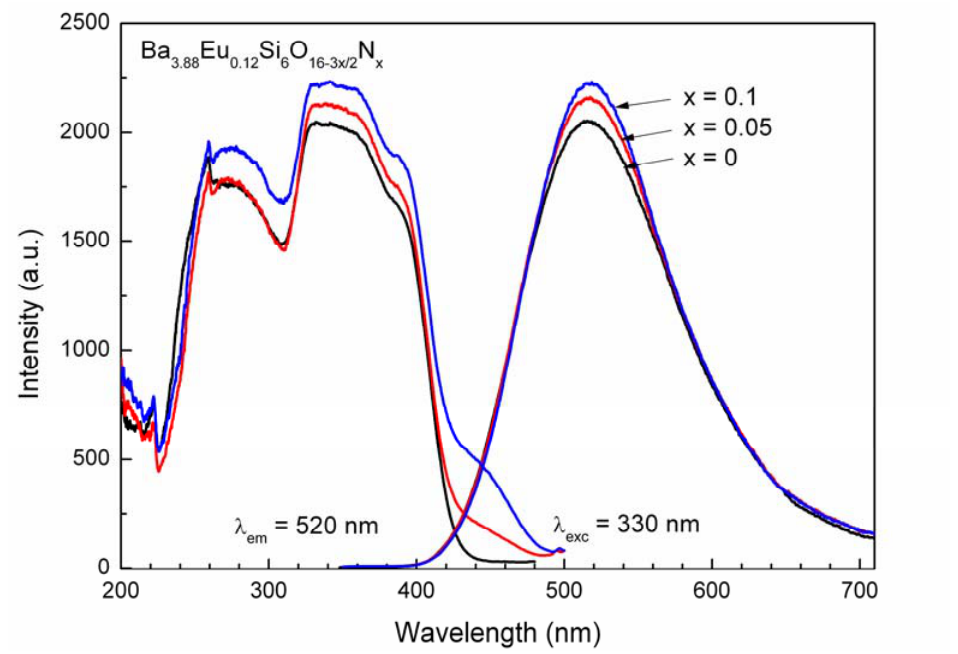
Figure 7. Excitation and emission spectra of Ba the nitrogen content